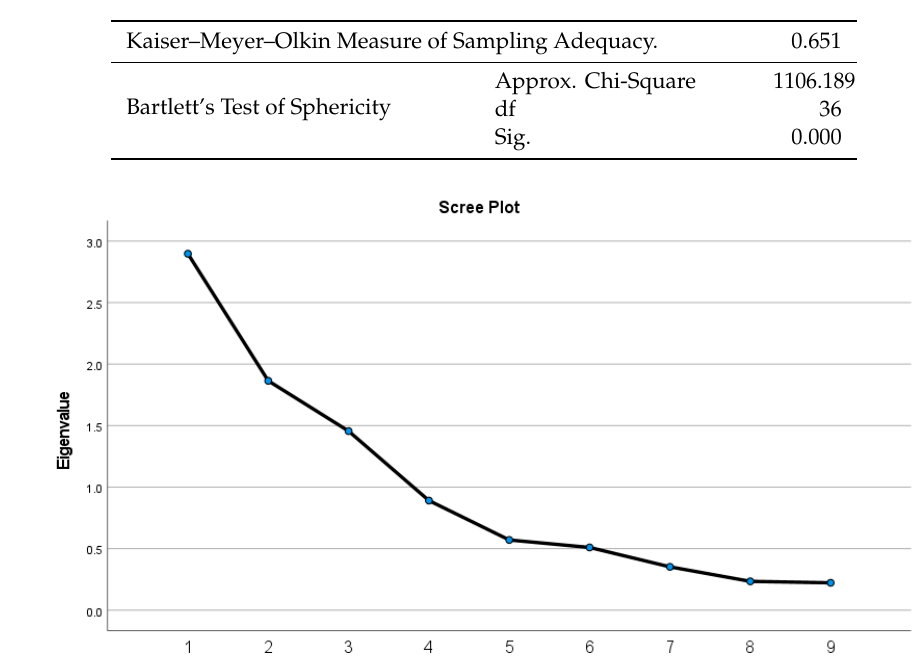
Table A3. KMO and Bartlett’s Test.